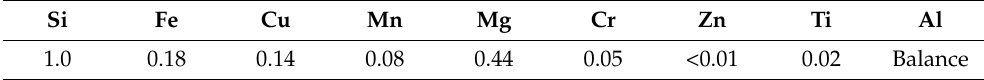
Table 1. Chemical composition of 6016-T6 aluminum alloy (wt%).